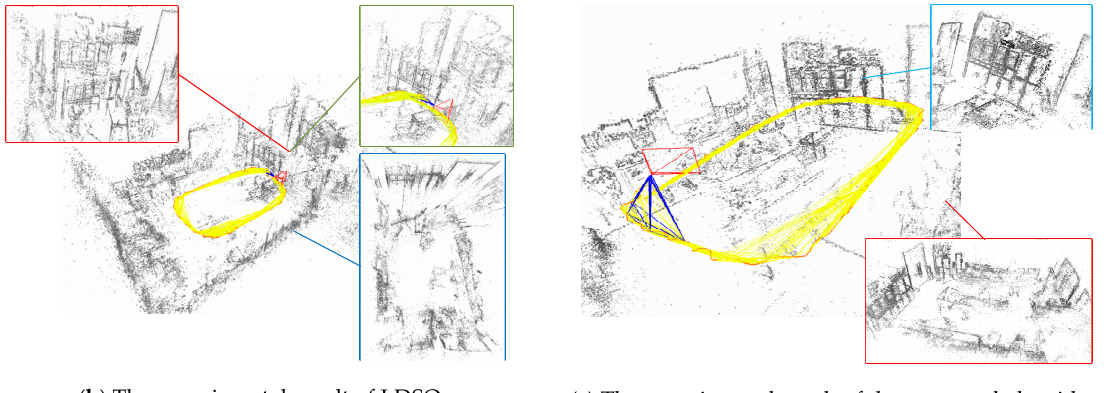
Figure 17. The actual environmental experiment of LDSO and the proposed algorithm. Subfigure ( a ) shows the adjusted environmental illumination during the experiment. Then, we tested the LDSO and proposed algorithm with respect to subfigure ( a